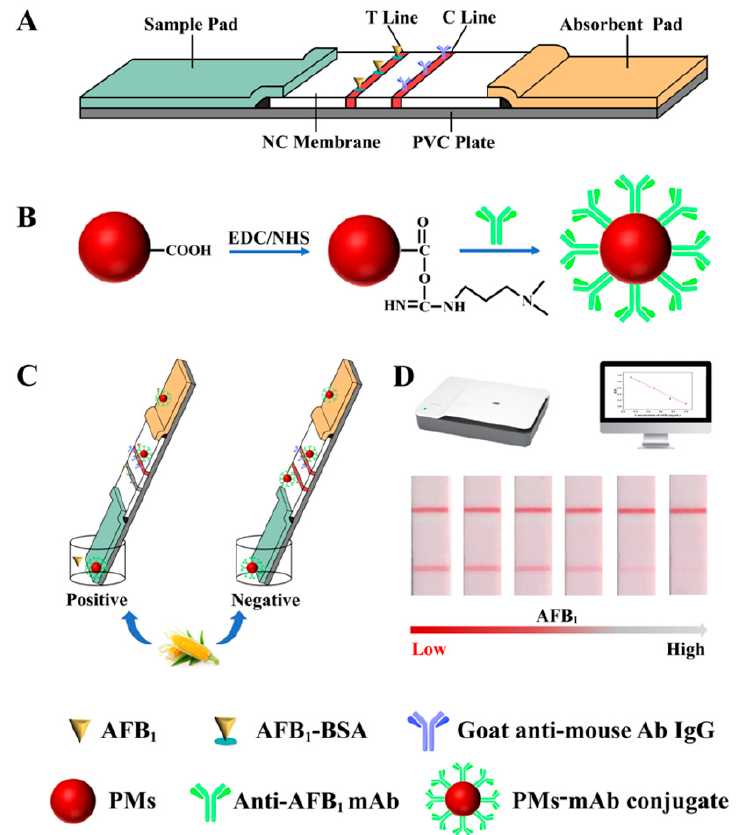
Figure 1. The scheme of the PMs-ICA. ( A ) The structure of the test strips, including a sample pad, a NC membrane, an absorbent pad, a PVC plate, and the AFB 1 -BSA, and goat anti-mouse antibody IgG were coated on the NC membrane form the T line and C line, respectively. ( B ) The process of labeling of mAbs with PMs. ( C ) Qualitative detection of the PMs-ICA. ( D ) Quantitative detection of the PMs-ICA.